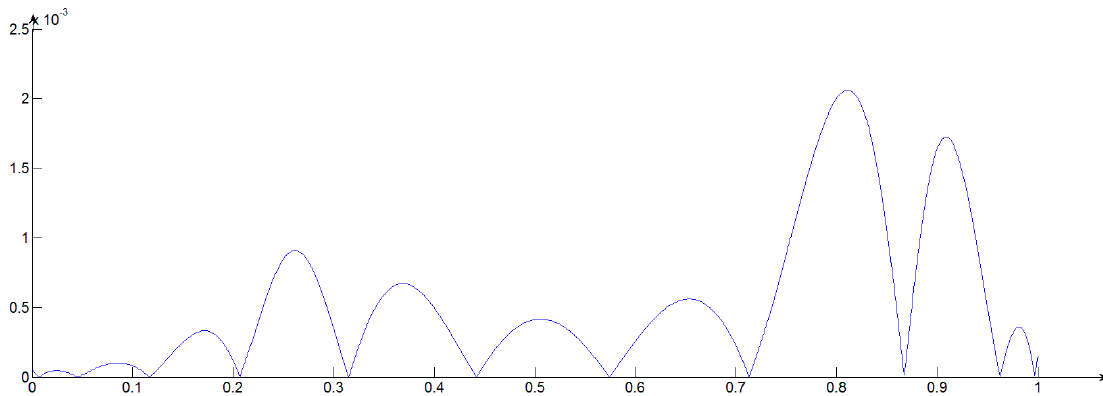
Figure 2. The septic Bézier curve and the offset. The original curve is the thin green curve with a control net. The offset is the red curve, and the approximating offset is the thick green curve.